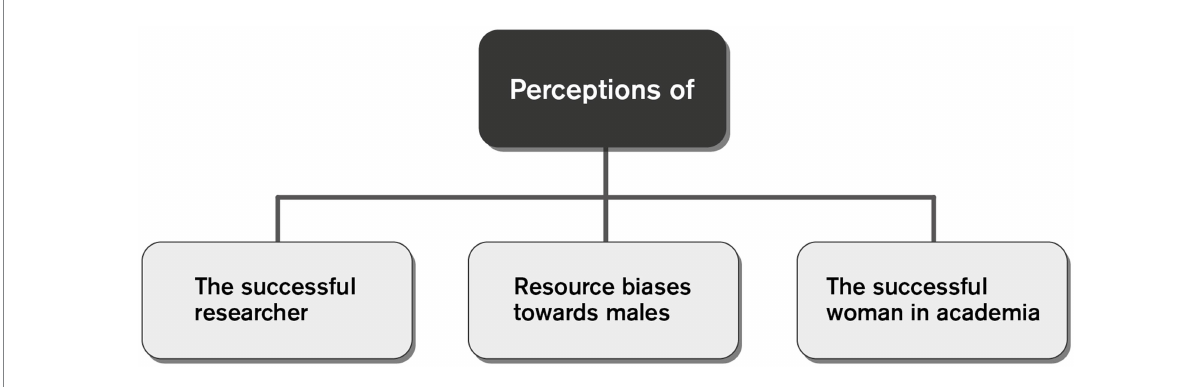
FIGURE 2 Sub-themes that emerged from the focus group discussions of the women employed as early-career researchers (WECRs’) views on their research career with the present allocation of resources and